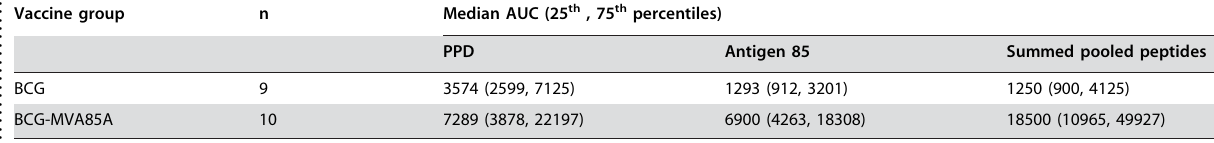
The area under the curve analysis was carried out between 0 and 24 weeks. doi:10.1371/journal.pone.0001052.t005 .